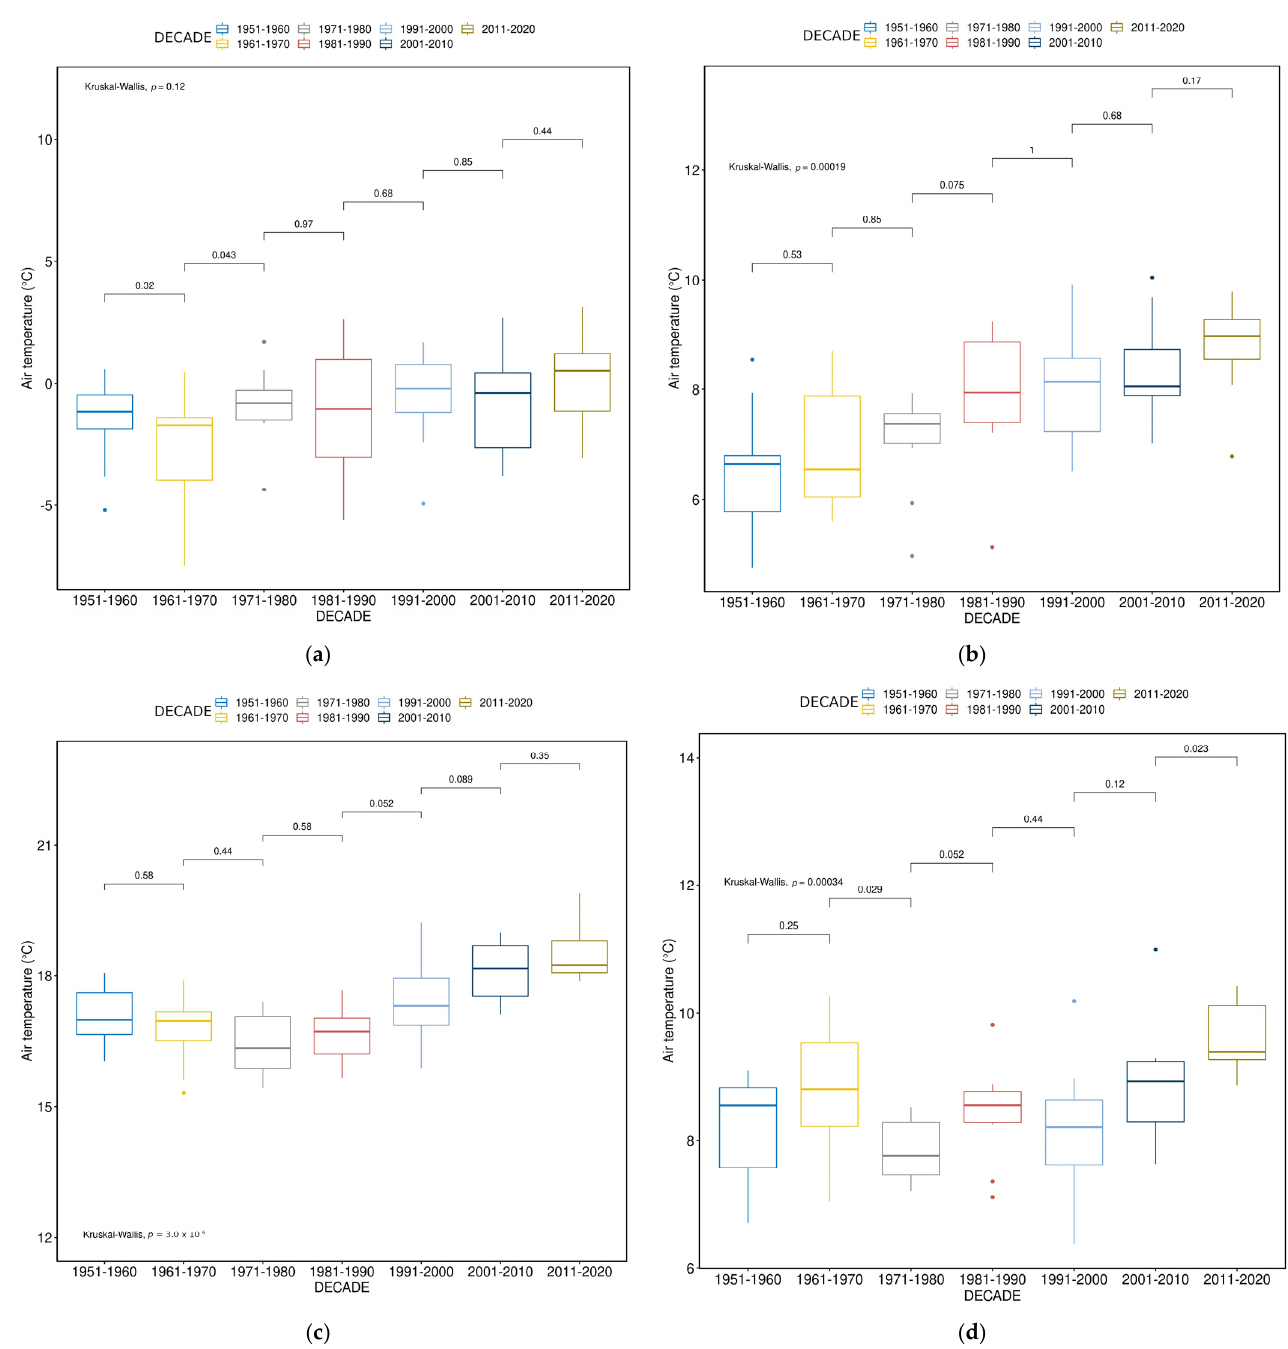
Figure 8. Box-and-whisker plots of seasonal average air temperature in Poland over the decades. The results of overall Kruskal–Wallis test and Wilcoxon test for inter-decadal differences are provided. ( a ) DJF; ( b ) MAM; ( c ) JJA; ( d ) SON.